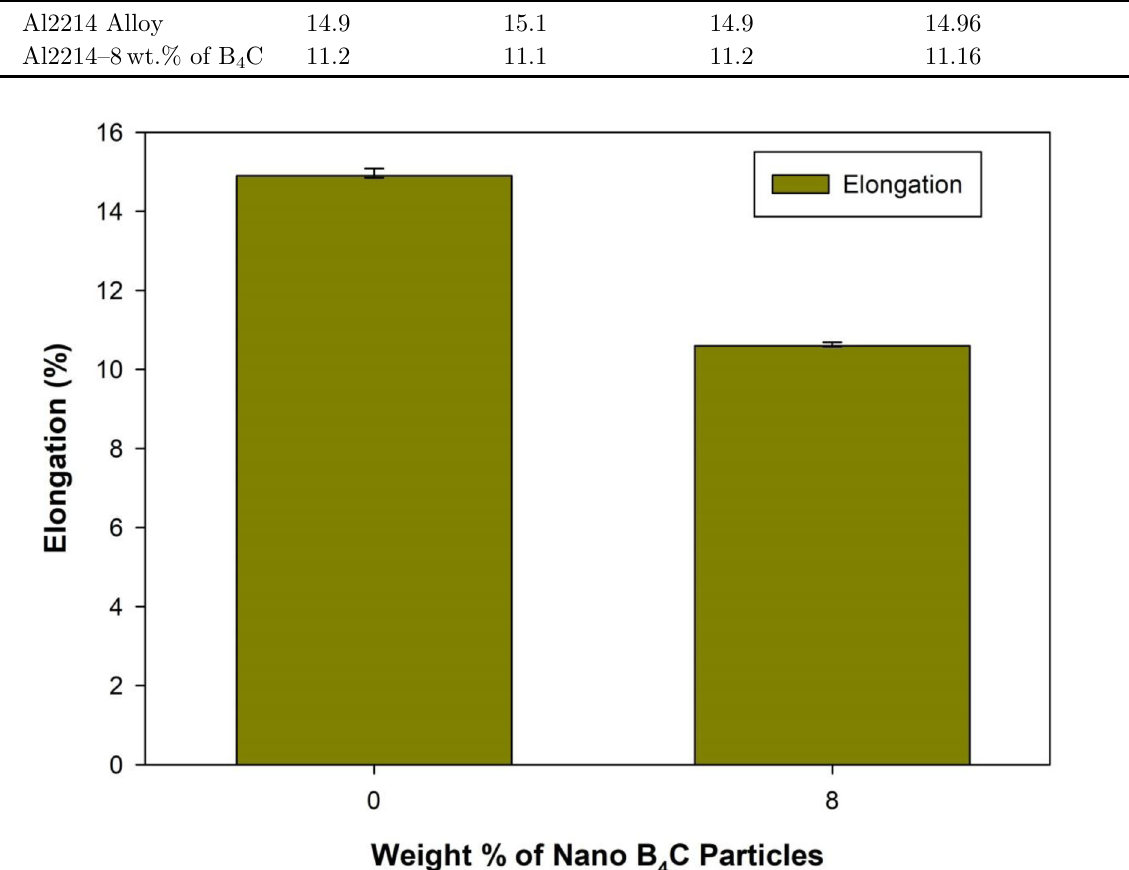
Table 5. Elongation of Al2214 alloy and B Sl